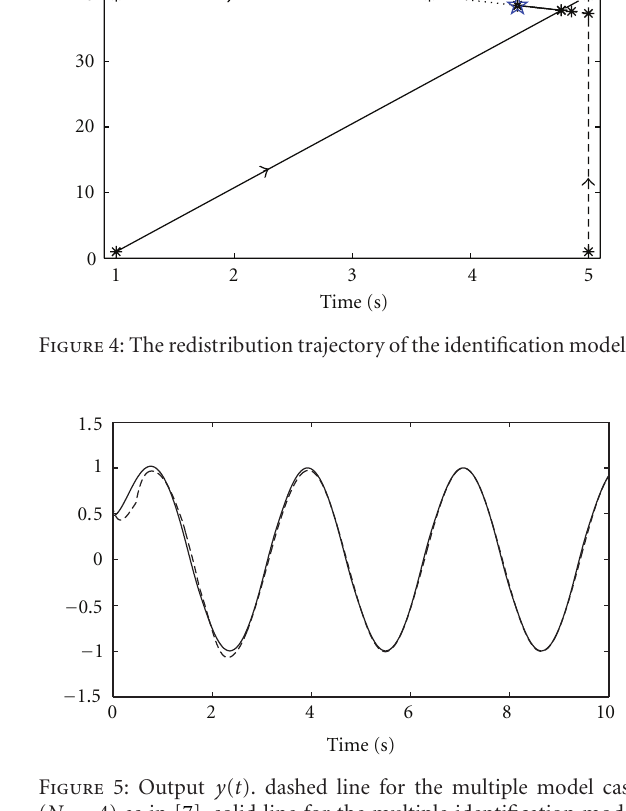
Figure 2: Control u ( t ) on the time interval [0, 0.06]. dash-dotted line for the classical adaptive control, dashed line for the multiple model case ( N = 200) as in [7], and solid line for the multiple identification model developed in this paper.